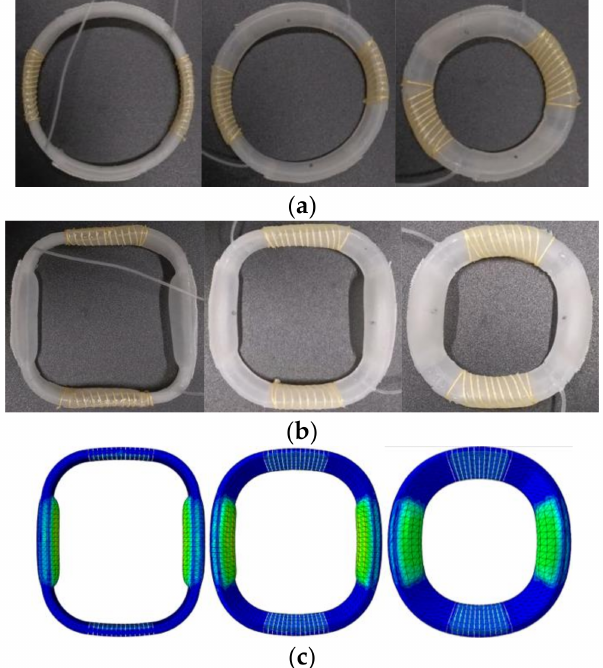
Figure 7. Performance testing of fiber-constrained annular flexible actuators. ( a ) Fiber-constrained annular flexible actuator in uninflated form; ( b ) fiber-constrained annular flexible actuator in inflated form; ( c ) simulated deformation effect of fiber-constrained annular flexible actuator.